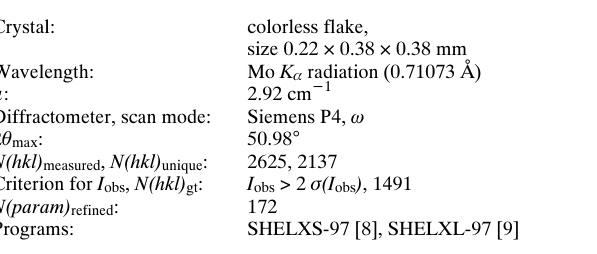
Table 1. Data collection and